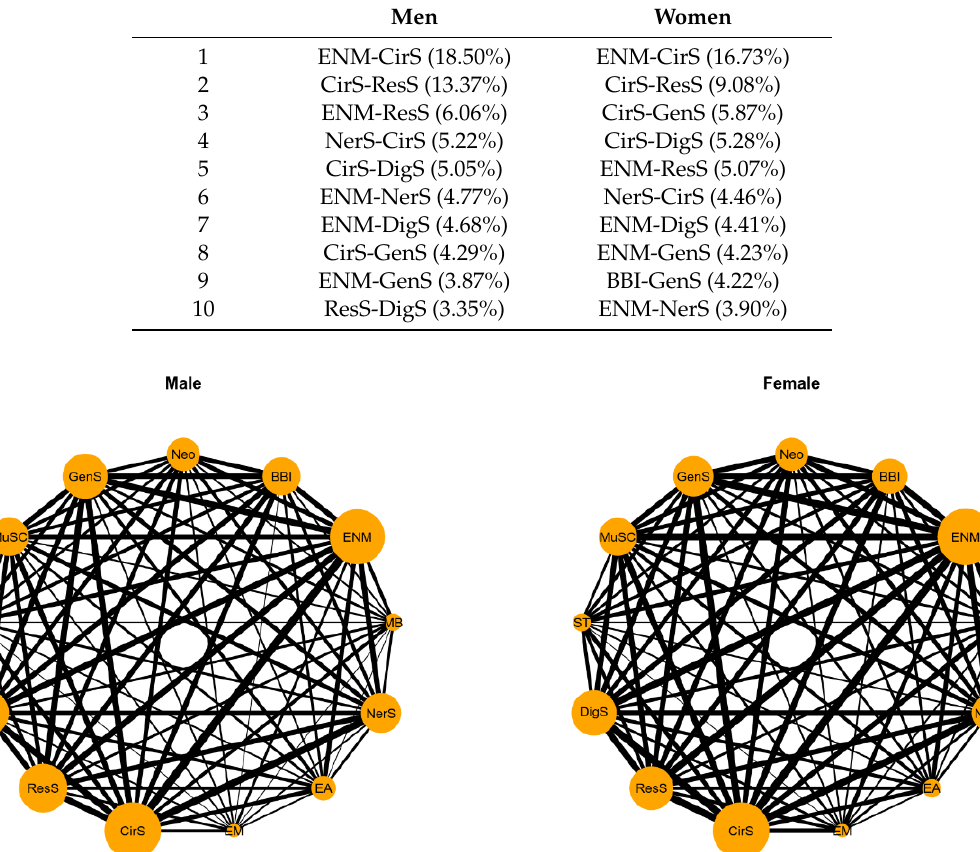
Table 3. The proportions of the ten most common two-disease combinations by gender.